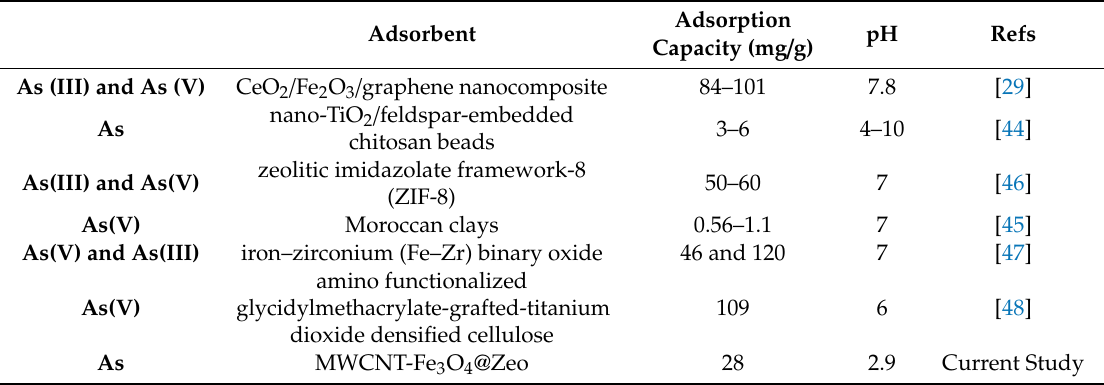
Table 4. Comparison of removal efficiency of arsenic between different adsorbents.